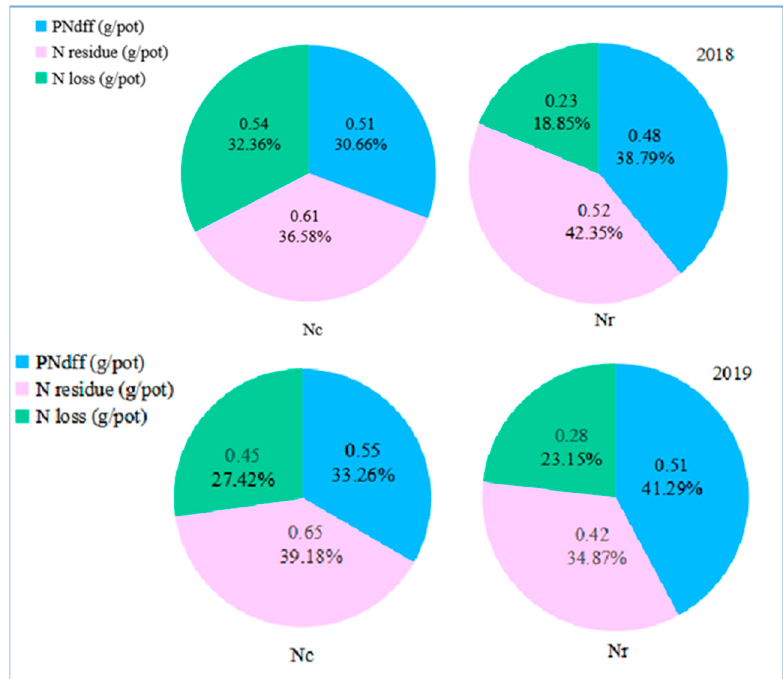
Figure 3. The fate of nitrogen fertilizer in the wheat season.